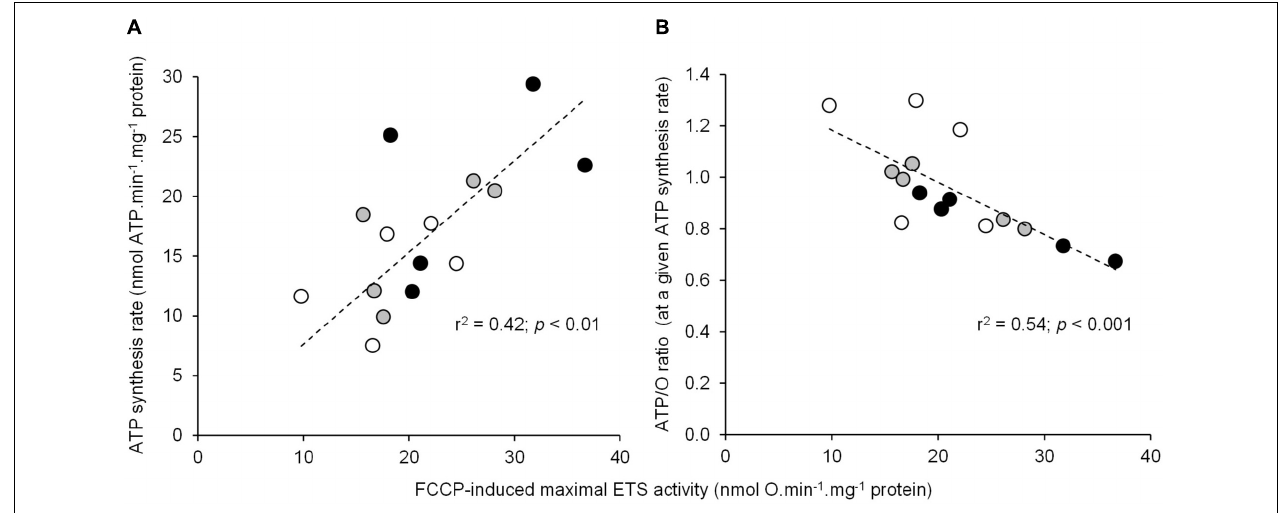
FIGURE 2 | Relationship between the individual maximal oxidative activities and the ATP synthesis rate or coupling efficiency. The correlation of mitochondrial FCCP-induced maximal ETS activity using succinate as the respiratory substrate with (A) the maximal rate of ATP synthesis (mean values are reported in Table 1 ) or (B) the coupling efficiency (ATP/O ratio) calculated at the highest common ATP synthesis rate (mean values are shown in Figure 1B ). Individual values show five independent mitochondrial preparations from the liver of toad measured at 20 ◦ C (white circles), at 25 ◦ C (gray circles), and at 30 ◦ C (black circles).